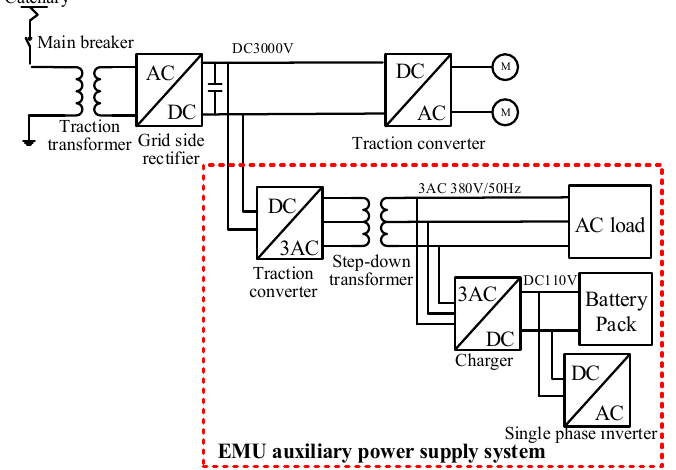
Figure 2. Topology diagram of the EMU auxiliary power supply system.